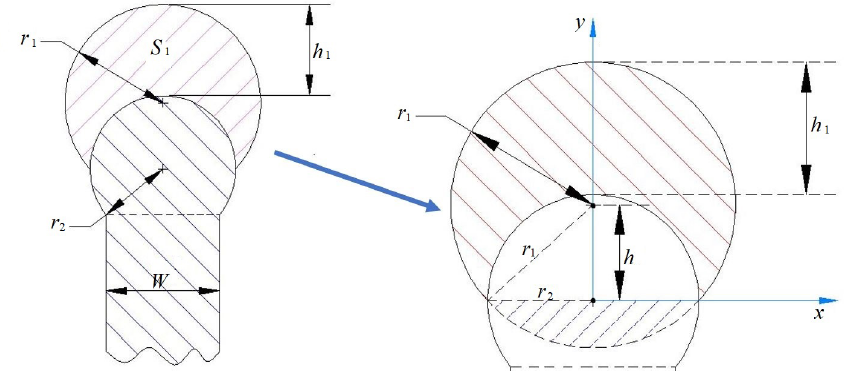
Figure 5. Profile of double additive remanufacturing